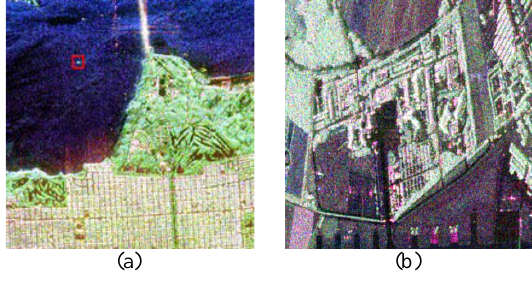
Figure 1.Original data based on the Pauli decomposition: (a) Original data of AIRSAR; and (b) Original data of